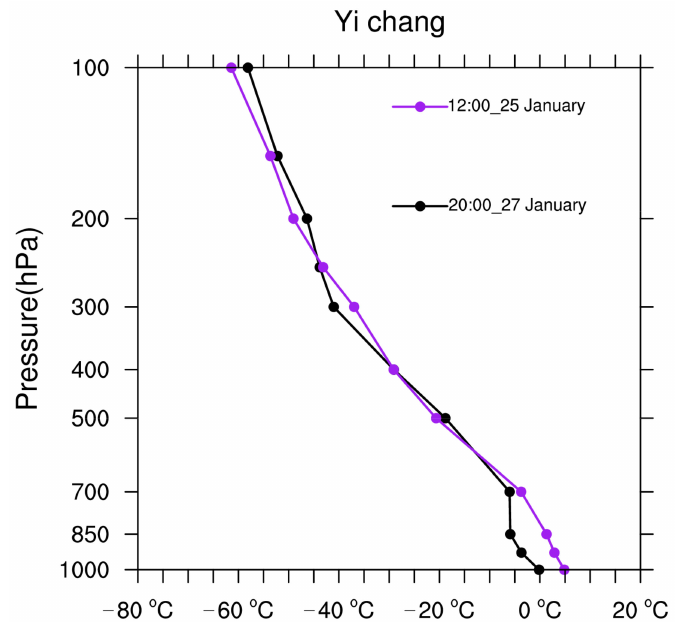
Figure 7. GIIRS temperature profiles in Yichang, Hubei province. The purple line was the GIIRS profile at 12:00 (Beijing time) on 25 January 2022. The black line was the GIIRS profile at 20:00 (Beijing time) on 27 January. The surface observation of the precipitation type was rain at 12:00 on 25 January, while it was snow at 20:00 on 27 January. The quality flags of purple profile are 3 (100 hPa), 3 (150 hPa), 0 (200 hPa), 1 (250 hPa), 2 (300 hPa), 2 (400 hPa), 0 (500 hPa), 0 (700 hPa), 1 (850 hPa), 1 (925 hPa), 0 (1000 hPa). The quality flags of black profile are 3 (100 hPa), 3 (150 hPa), 2 (200 hPa), 1 (250 hPa), 3 (300 hPa), 0 (400 hPa), 0 (500 hPa), 1 (700 hPa), 0 (850 hPa), 0 (925 hPa), 0 (1000 hPa). The